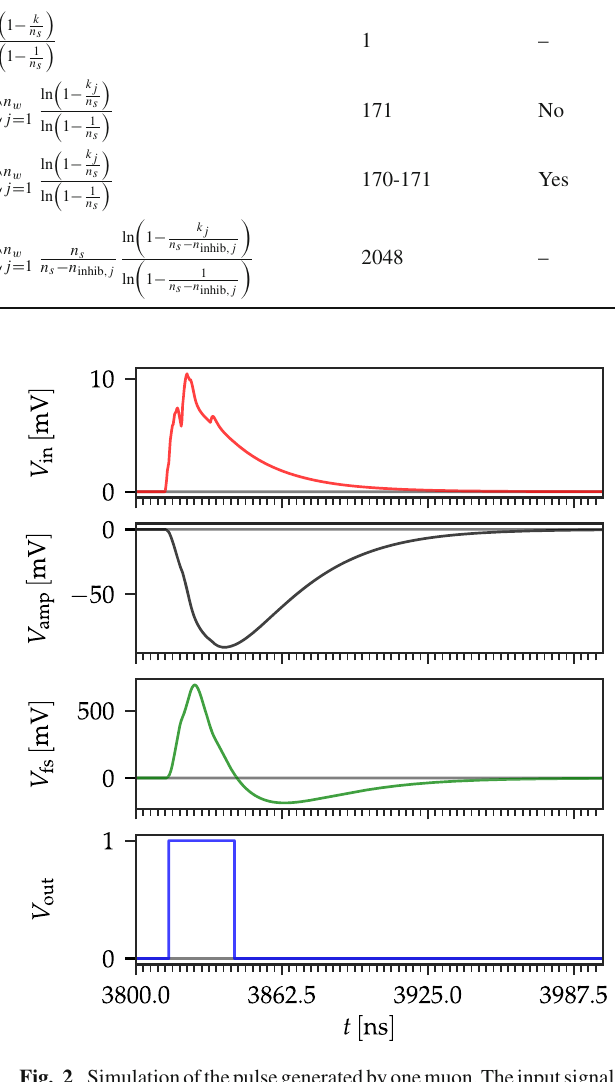
Fig. 2 Simulationofthepulsegeneratedbyonemuon.Theinputsignal (top) generated at the SiPM goes through a pre-amplifier (second), a fast shaper (third), and a discriminator and FPGA (bottom). The output signal is digitized into 3 . 125ns-wide time intervals by the